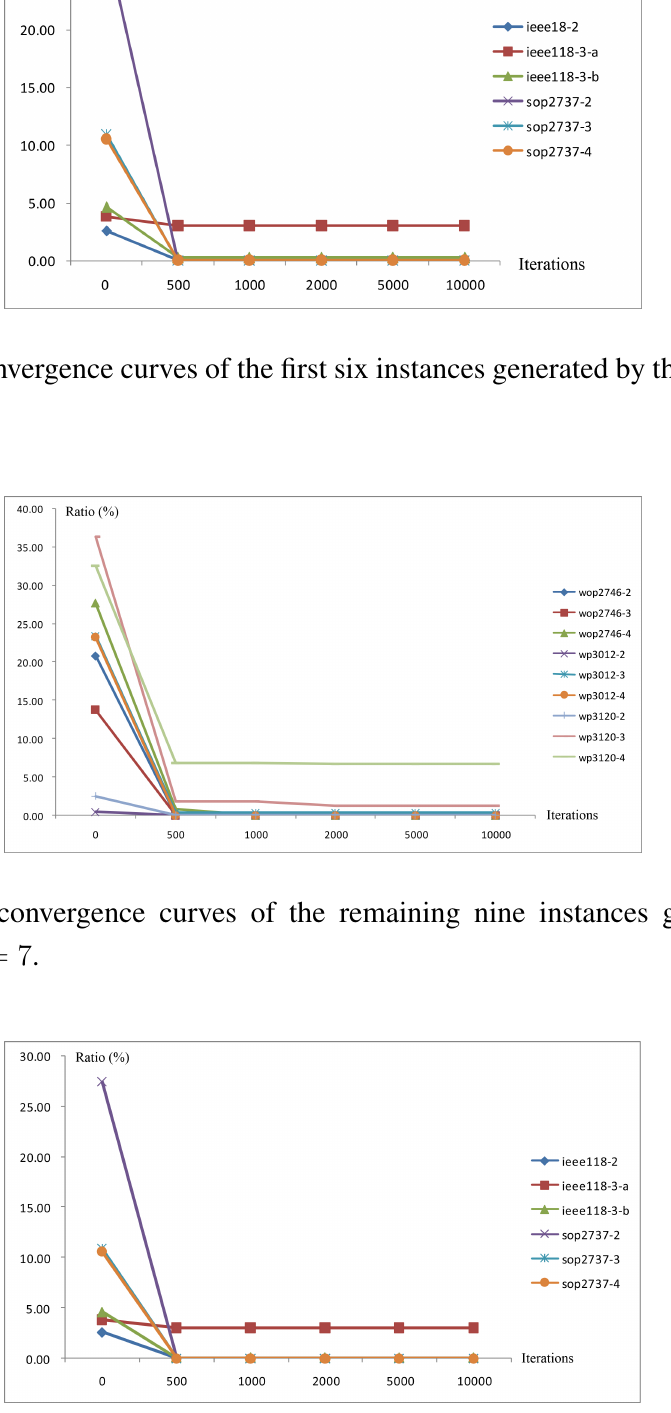
Figure 12. The convergence curves of the first six instances generated by the algorithm with L = 15